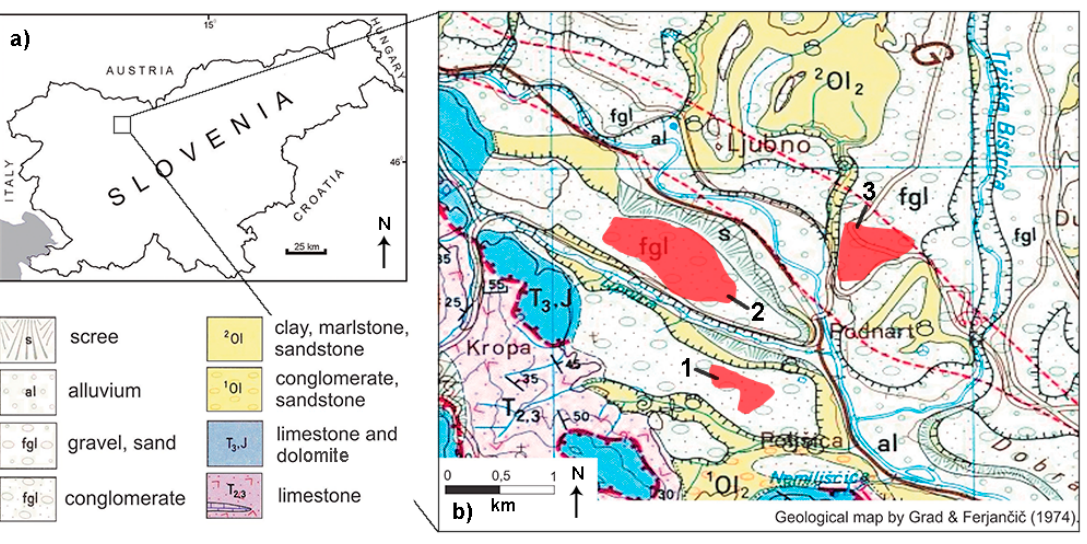
Figure 1. ( a ) The location of the study area; ( b ) A geological map [17] of the study area with three test sites (1: Poljšica; 2: Dobrava; 3: Podbrezje).